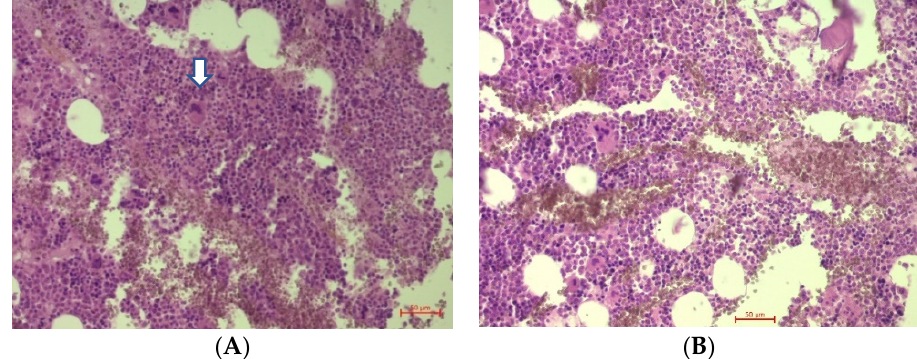
Figure 6. ( A , B ) Bone marrow at 20 × magnification. Bone marrow was normocellular, haematopoiesis is maintained, small–medium-sized megakaryocytes (arrow).